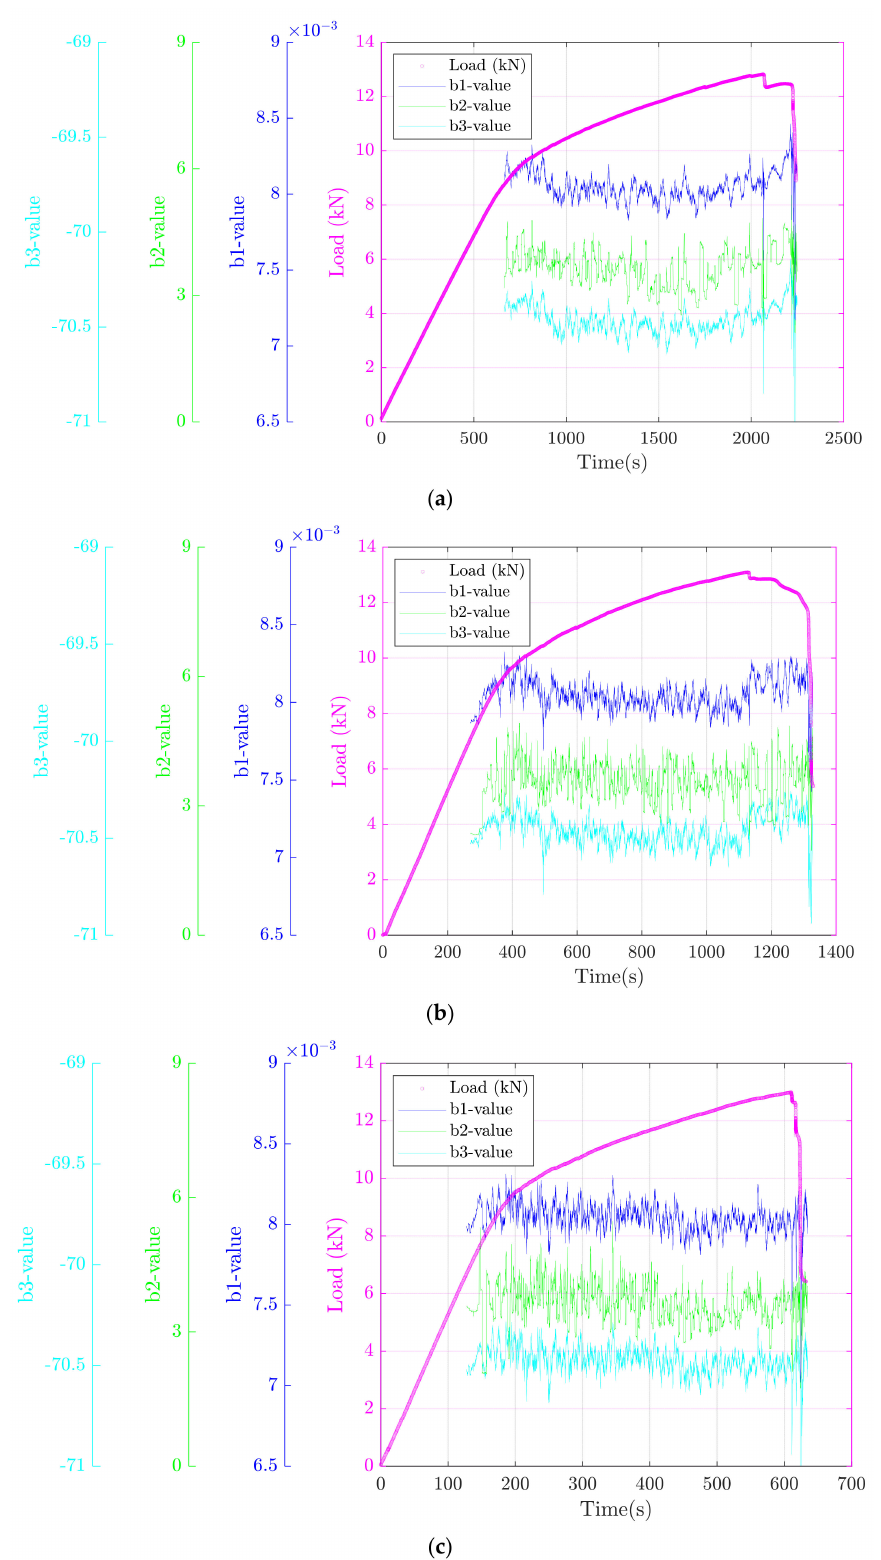
Figure 10. Evolution of the three types of b-values during the performed mechanical loading